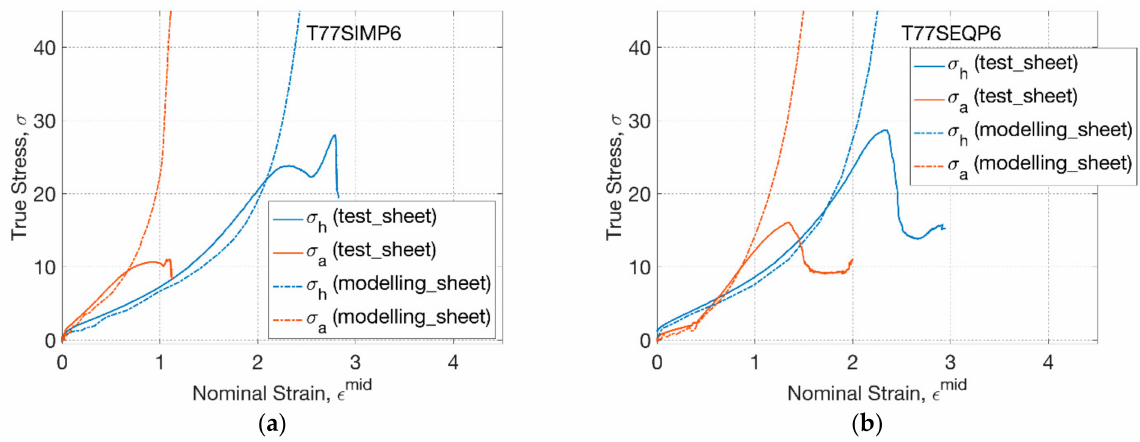
Figure 8. Constitutive modelling of sheets under replicative biaxial test: ( a ) T77SIMP6, ( b ) T77SEQP6.